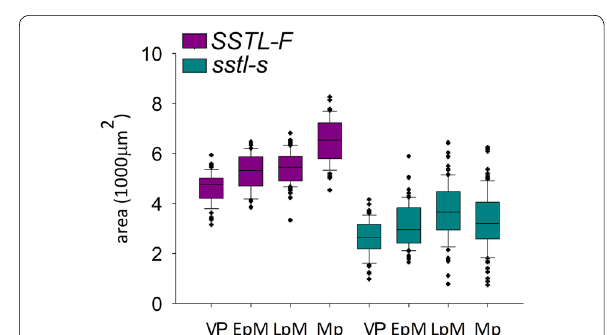
Fig. 5 Area of anther locules in SSTL ‑ F and sstl ‑ s . More than 20 individual anthers were calculated from each sample stage. VP vacuolated pollen stage, EpM early pollen mitosis stage, LpM late pollen mitosis stage, Mp mature pollen stage. Horizontal line is median, box edges are Q1–Q3 and whiskers are